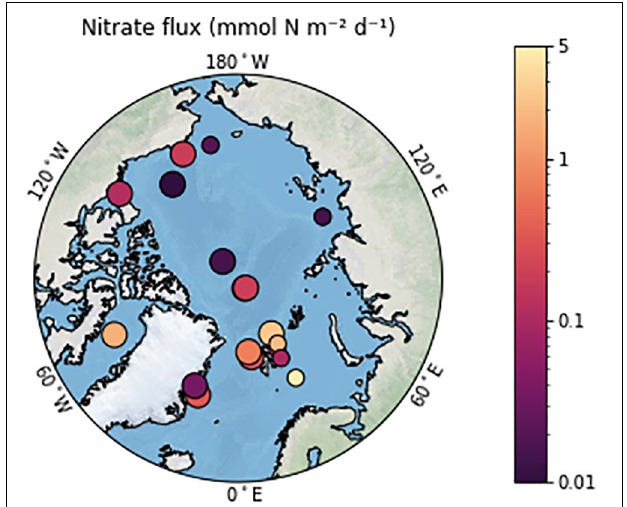
FIGURE 2 | All nitrate flux compilation across the Arctic Ocean compiled for this study, irrespective of season and vertical levels. The smaller dots indicate single stations, whereas the big dots represent averages over larger time or space